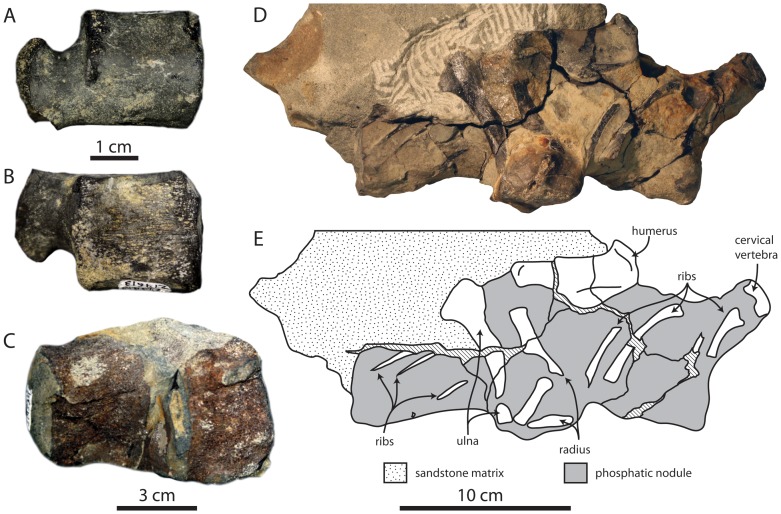
Examples of articulated remains in phosphatic nodules.(A) Odontocete caudal vertebrae in near articulation from Bonebed 6 (UCMP 219584); (B) reverse. (C) Articulated odontocete caudal vertebrae in phosphate nodule from Bonebed 6 (UCMP 219613). (D) Fur seal (Thalassoleon sp., cf. T. macnallyae) articulated partial skeleton in phosphate nodule from Bonebed 4 (UCMP 219671); diagram of skeleton in E.